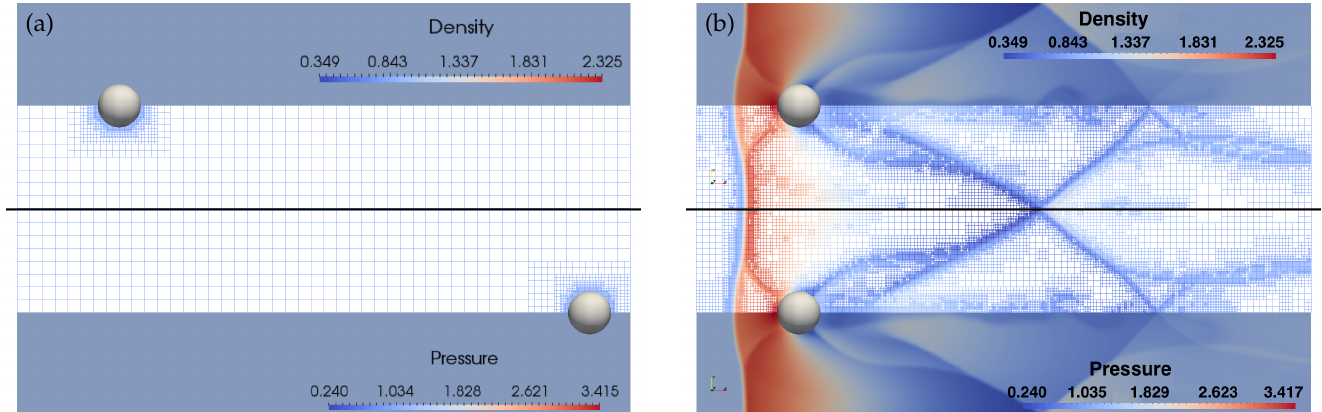
Figure 7. Density and pressure field plots for fixed (upper half) and moving (bottom half) solid disks at ( a ) the beginning and ( b ) the end of